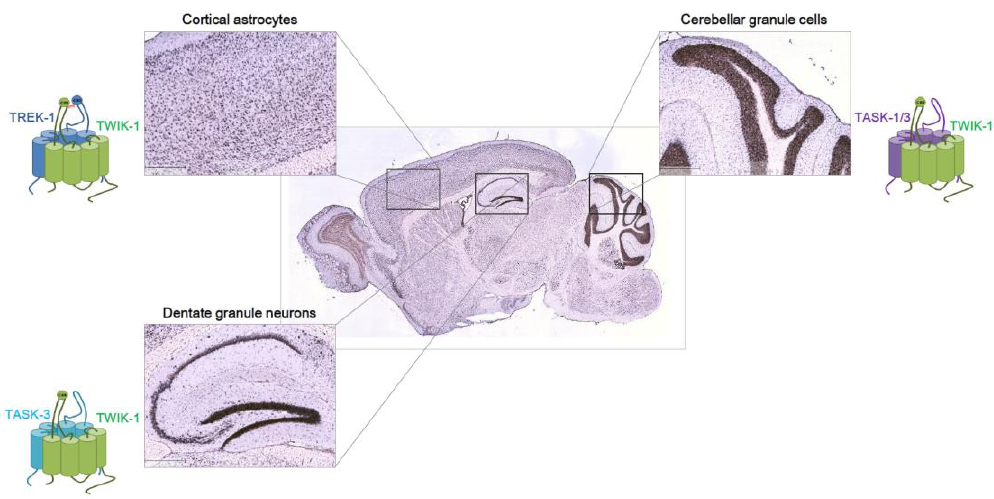
Figure 1. Heterodimeric K2Ps in the brain. Expression pattern of mouse TWIK-1 (TWIK—tandem of pore domains in a weak inward rectifying K + channel) from Allen Brain Atlas database. In situ hybridization of TWIK-1 is shown in a sagittal section of mouse brain at P56. Shown are higher magnification of cortex ( top left ), hippocampus ( bottom left ), cerebellum ( top right ), and medulla ( bottom right ) from serial sections. Scale bar: 419 μm. Note that TWIK-1 can function as either a homodimeric or heterodimeric channel. Based on the reports that TWIK-1 heterodimeric channels function in three brain regions [20,26,35], we believe TWIK-1 acts as heterodimeric channels with other K2P partners in other brain regions. Functional heterodimerization of TREK-1/TWIK-1 in cortical astrocytes [20], TWIK-1/TASK-1/-3 in cerebellar granule cells [26], and TWIK-1/TASK-3 [35] in dentate granule neurons have been reported.